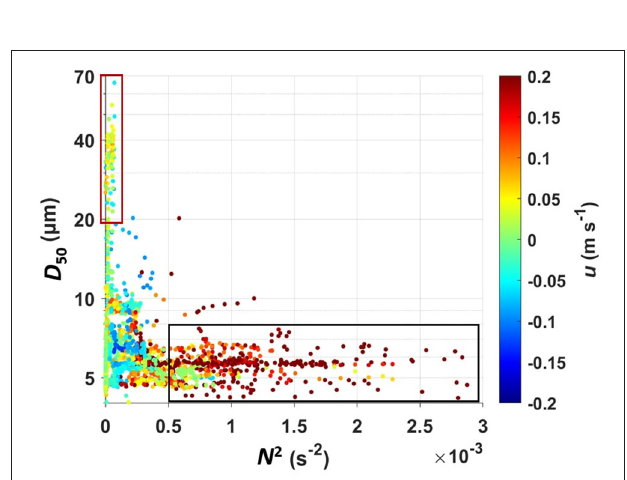
FIGURE 9 | Relationship between N 2 , D 50 , and the normal component u of the current (colorbar, m s − 1 ) at stations P1, P2, P3-a, and P3-b. Black box: interflow conditions. Red box: water mass below the